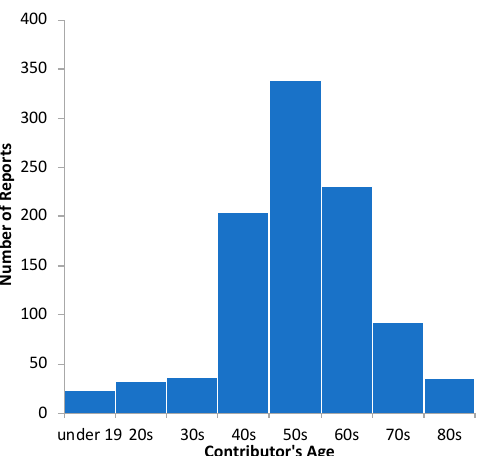
Figure 5. The generational distribution of contributors to Chiba-repo.